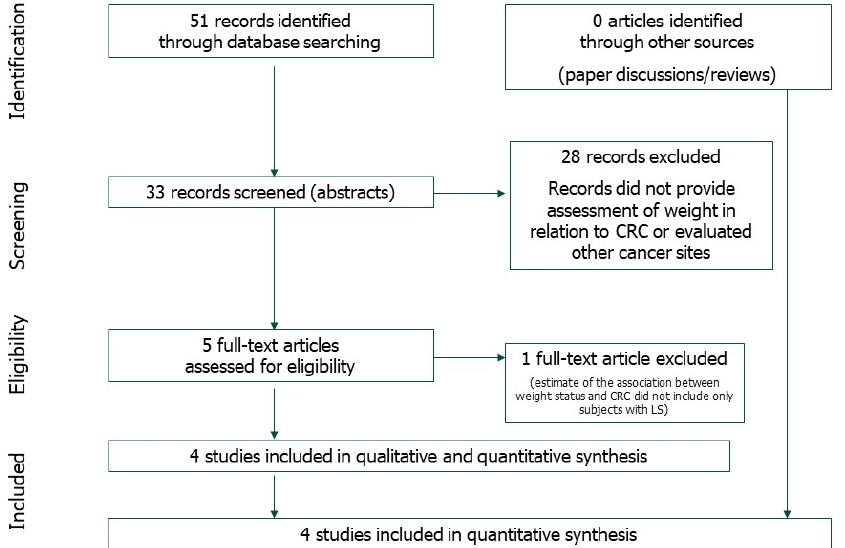
Figure 1. Selection process (flowchart).